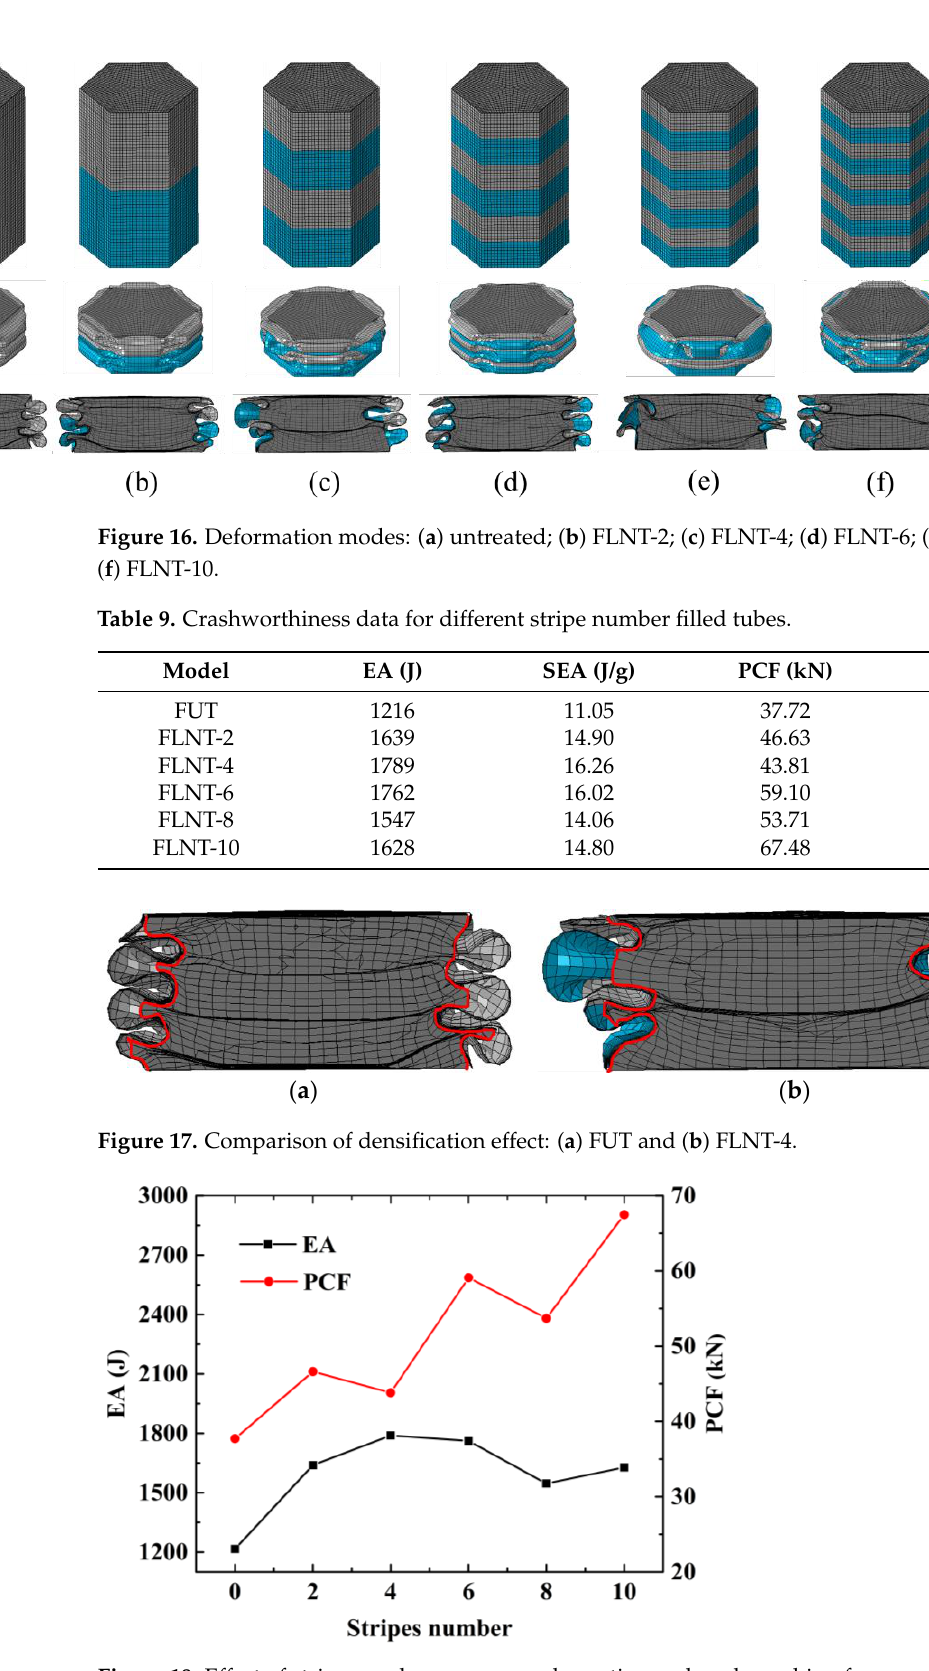
Figure 18. Effect of stripe number on energy absorption and peak crushing force.